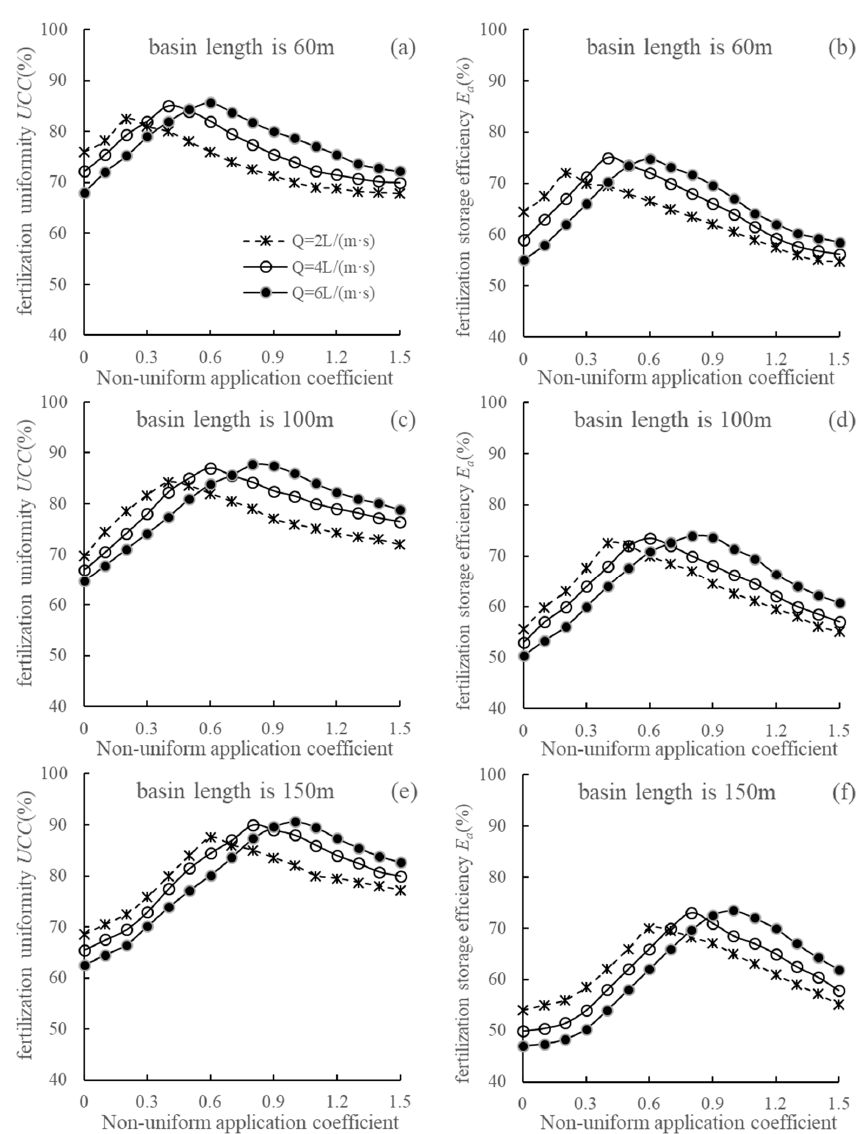
Figure 8. Trend of fertilization uniformity and fertilization storage efficiency under different non-uniform application coefficient. ( a , c , e ) shows the trend of fertilization uniformity under different non-uniform application coefficients when the basin length was 60 m,100 m and 150 m respectively; And (b , d , f ) shows the trend of fertilization storage efficiency under different non-uniform application coefficients when the basin length was 60 m, 100 m and 150 m respectively.